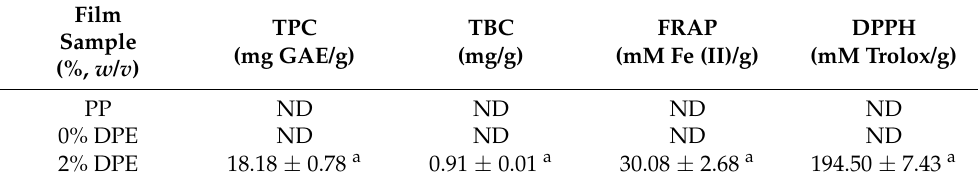
Table 3. Bioactive compound and antioxidant properties of the films.